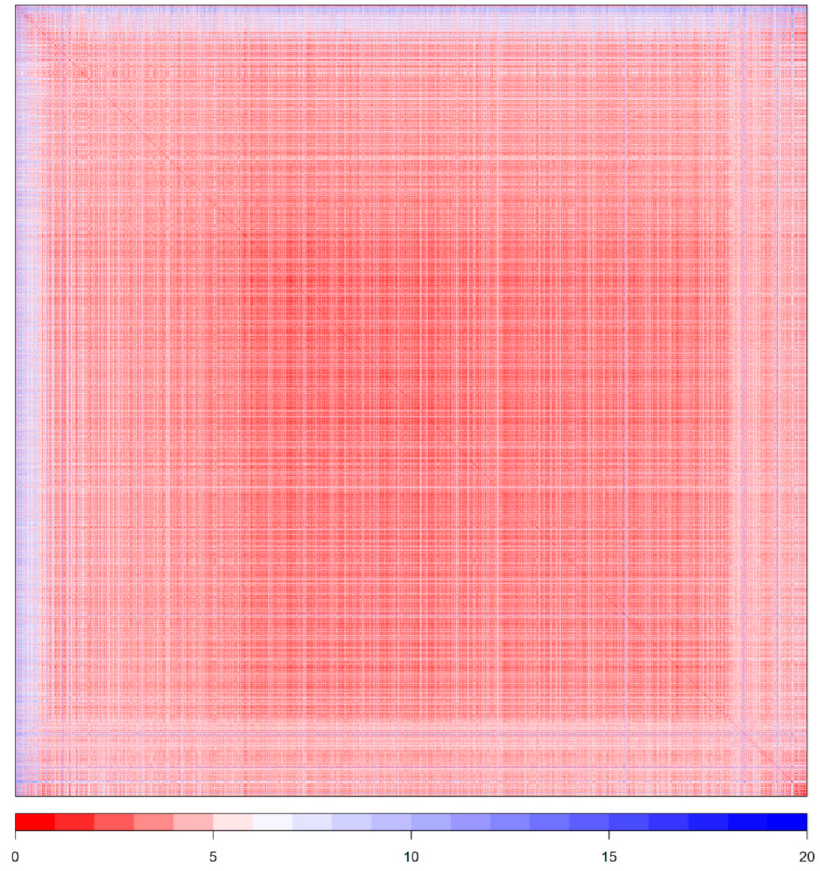
Figure 1. Dissimilarity plot based on the Tanimoto coefficient for the training data set used in this study. Lower values (more intense red) indicate lower dissimilarity (zero values showing identity the diagonal line). Spectral seriation was used between clusters and multidimensional scaling (“MDS”) within